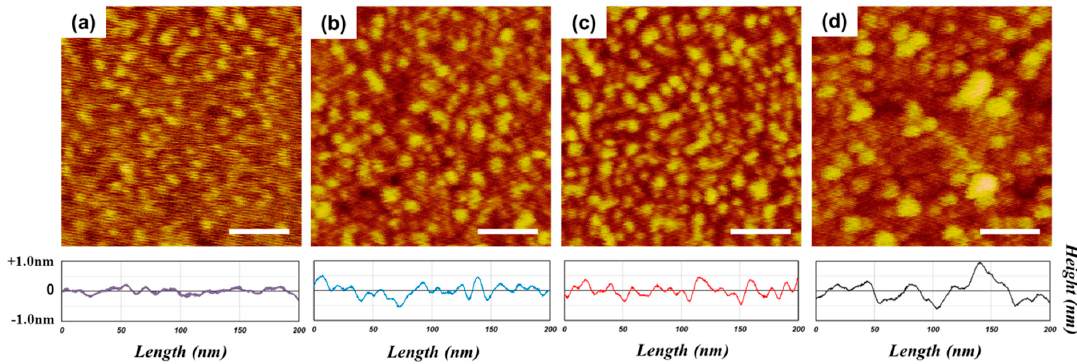
Figure 3. High-resolution tapping mode atomic force microscope (HR-AFM) images of ( a ) pure BQ; ( b ) BQ:HQ = 1:0.5; ( c ) BQ:HQ = 1:1; and ( d ) BQ:HQ = 1:1.5 mixture ratios (scan scale = 200 nm × 200 nm; scale bar = 50 nm).